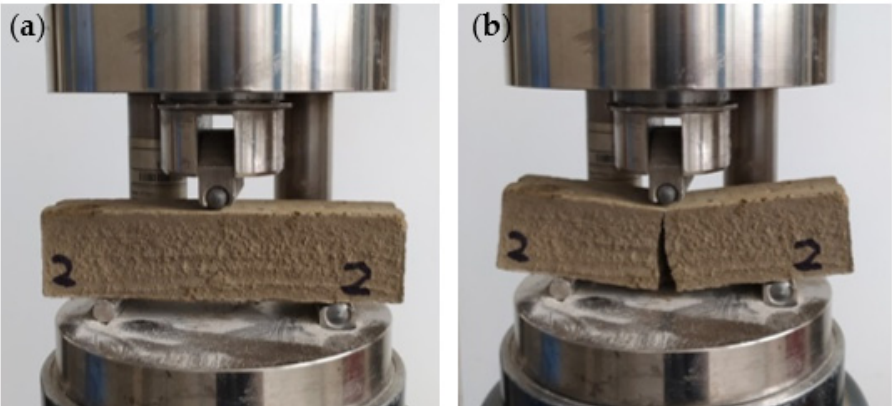
Figure 13. Three-point bending test performed on M1–M4 mortar specimens at the “TecnoLab” laboratory: ( a ) pre-test; and ( b ) post-test. Table 9. Bending and compressive strength of mortars